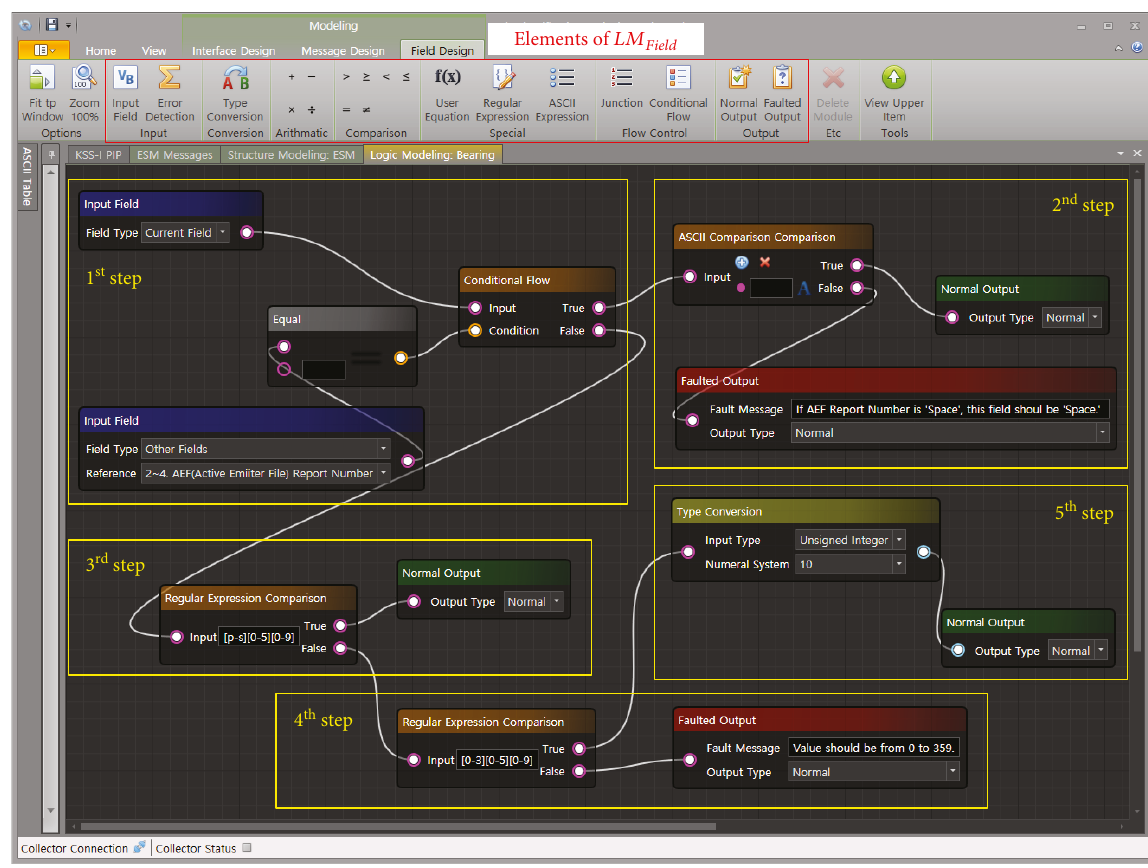
Figure 7: Logic modeling of bearing fi eld in ESM message. Table 5: Overall design of tests during system design and integration